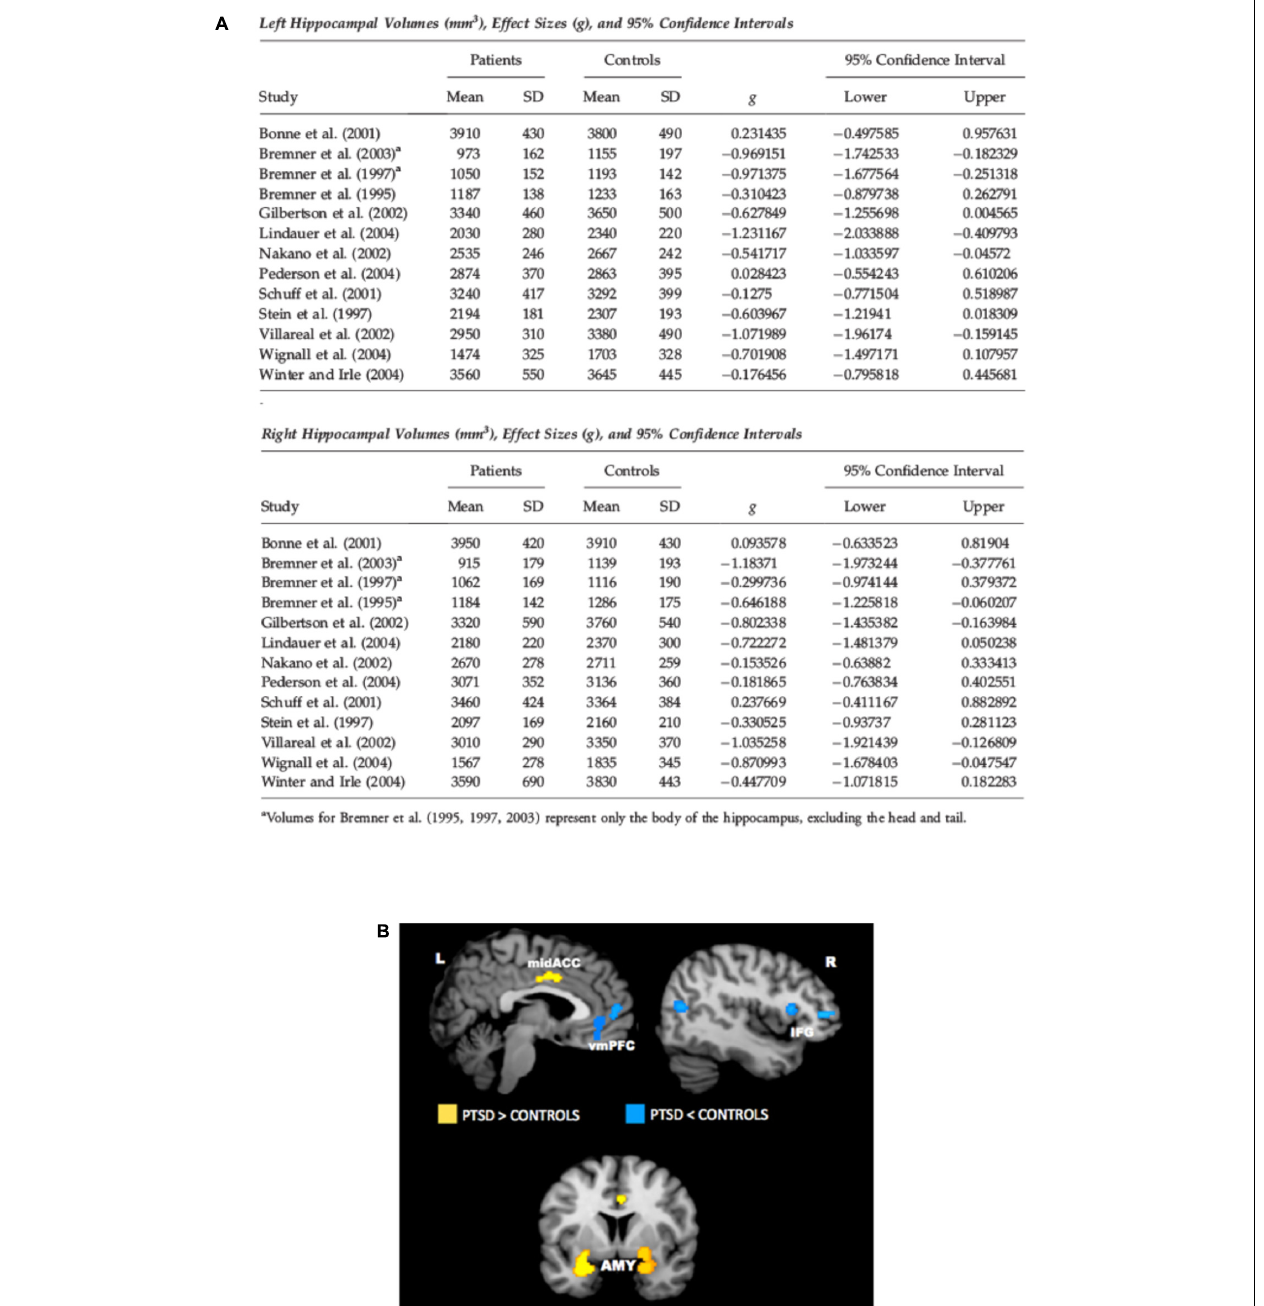
Frontiers in Pharmacology |